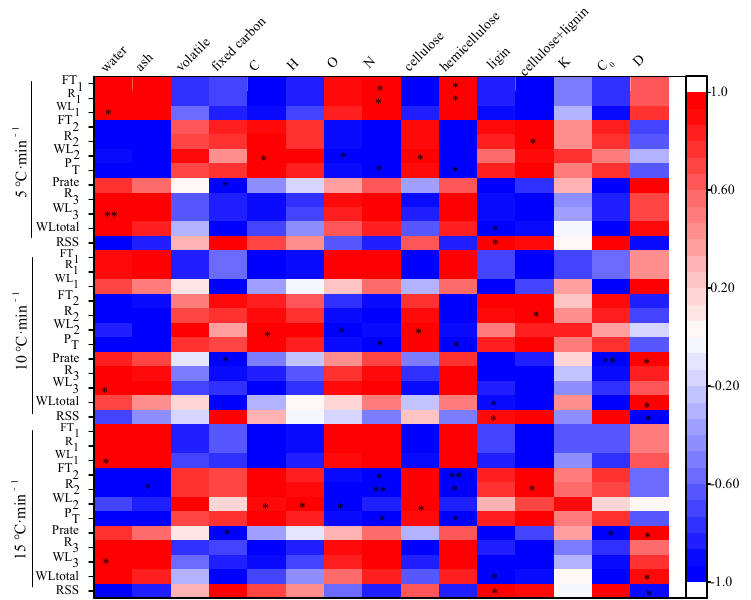
Figure 2. Correlation coefficient matrix of biomass composition and thermal characteristic parameters; * means p < 0.05, ** means p < 0.01.